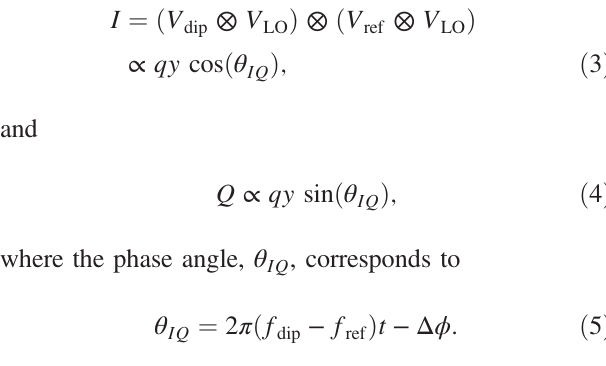
FIG. 7. Block diagram of the FONT5A digital board showing the primary input and output signals